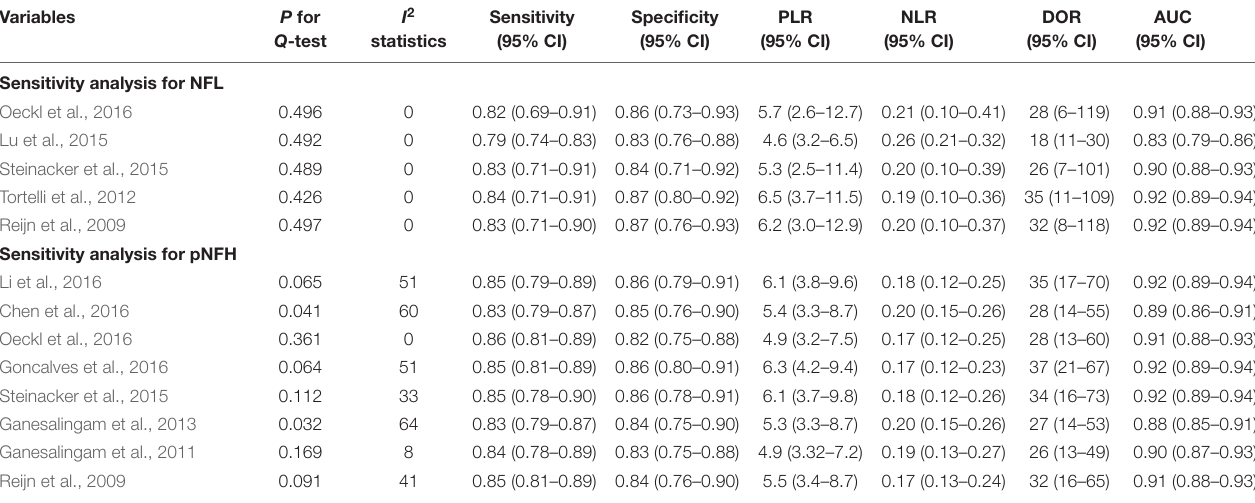
TABLE 2 | Results of sensitivity analyses.